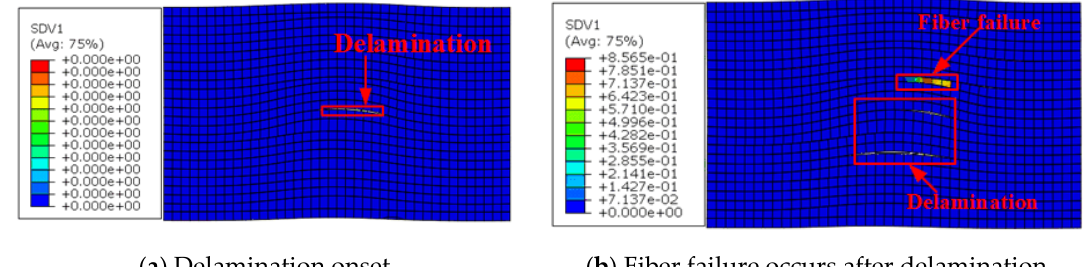
Figure 16. Elastoplastic model prediction of damage sequence for a laminate with wrinkle level 9.9°.